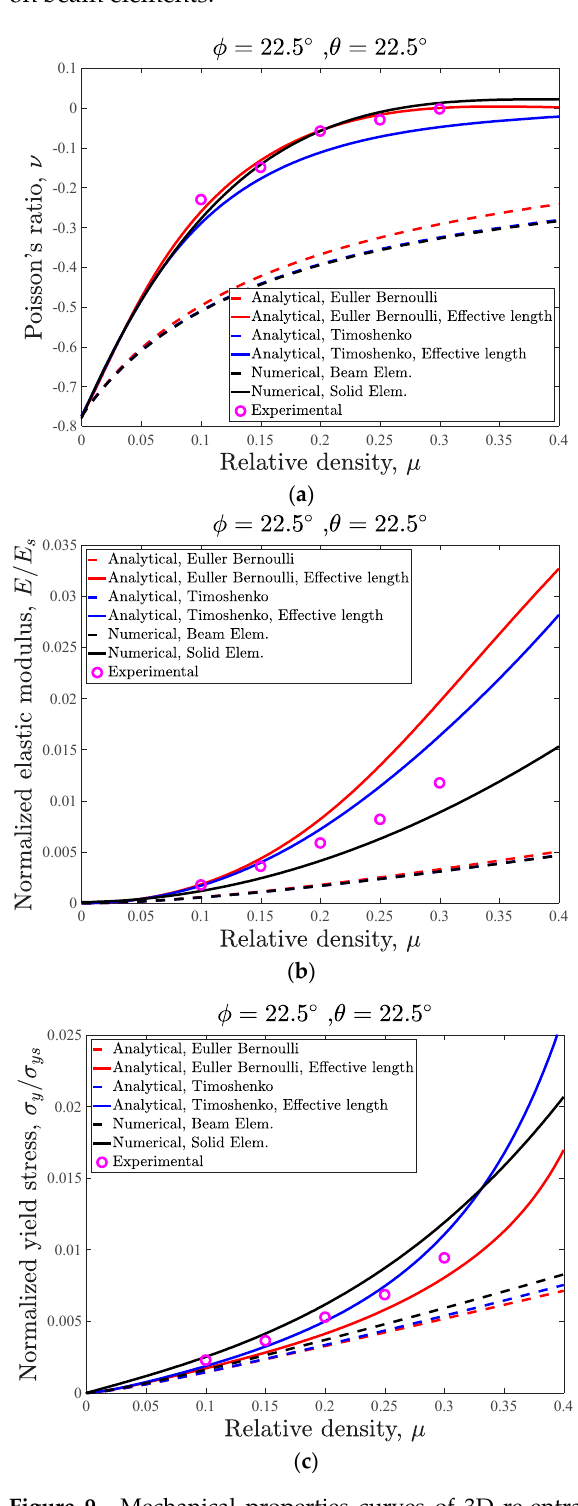
Figure 9. Mechanical properties curves of 3D re-entrant structure with 𝜑 = 22.5,𝜃 = 22.5 : ( a ) Poisson’s ratio, ( b ) elastic modulus, and ( c ) yield stress.